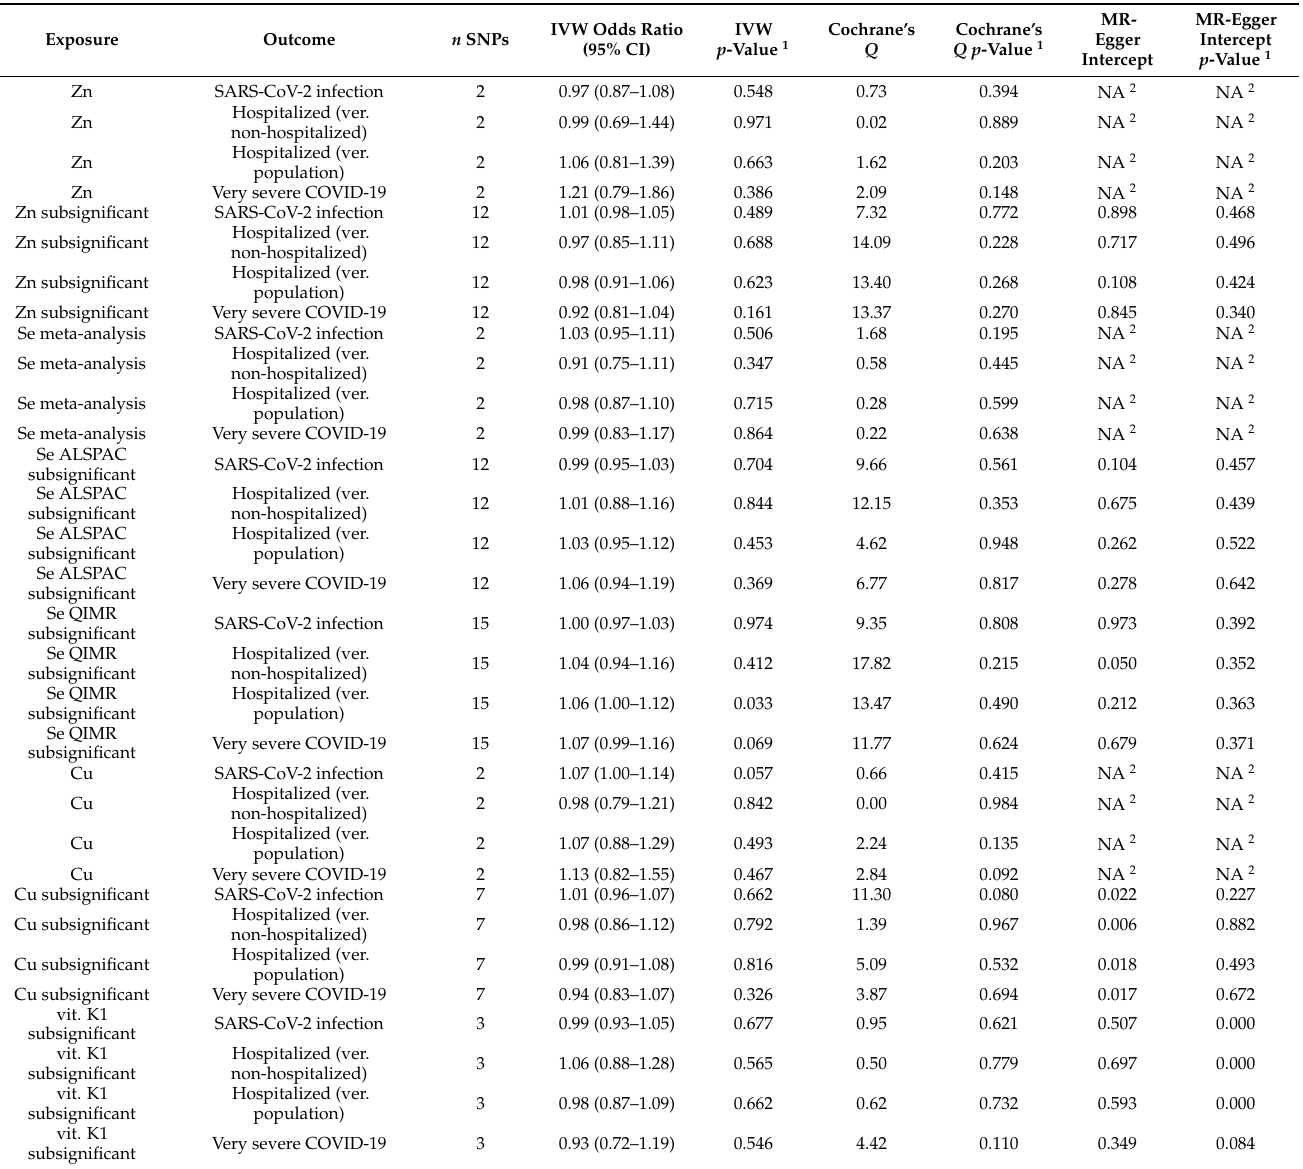
Table 1. Results of MR analysis studying the effect of circulating zinc (Zn), selenium (Se), copper (Cu) and vitamin K 1 concentration on 3 COVID-19 outcomes. Inverse-variance weighted (IVW)-based odds ratios, their p -values along with Cochrane’s Q statistic and MR-Egger intercept are presented. We used two sets of instruments whenever possible: Zn/Se/Cu refers to instruments with p -values < 5 × 10 − 8 and Zn/Se/Cu/vit. K 1 sub-significant refers to instruments with p -values < 5 × 10 − 5